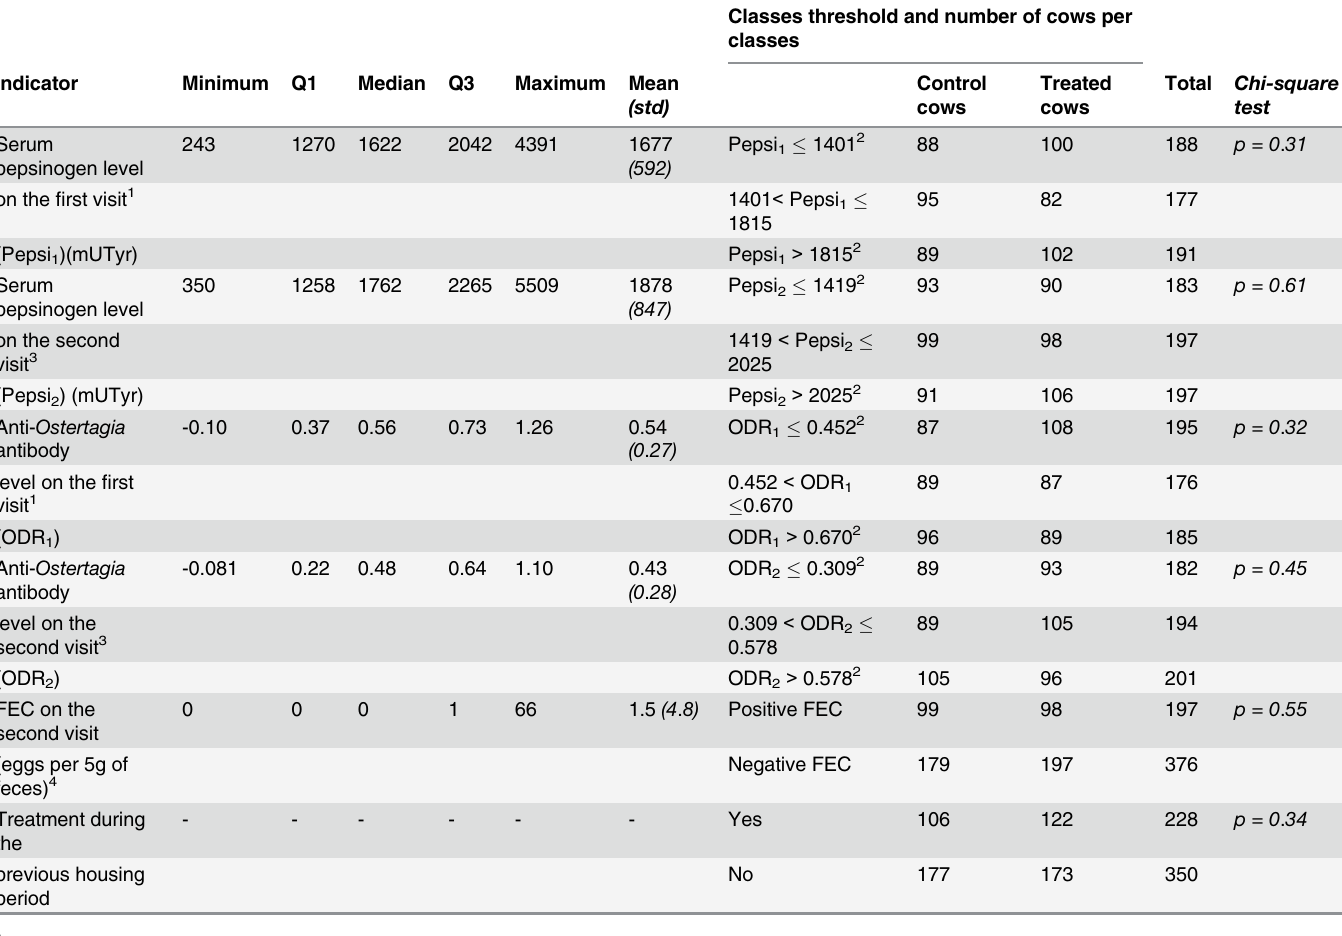
Table 3. Description of the dataset (578 cows in 13 herds, 295 treated cows, 283 control cows): distribution and classification of individual parasi- tological indicators characterizing cows, number of treated cows and control cows per classes for each categorized indicator. Classes threshold and number of cows per